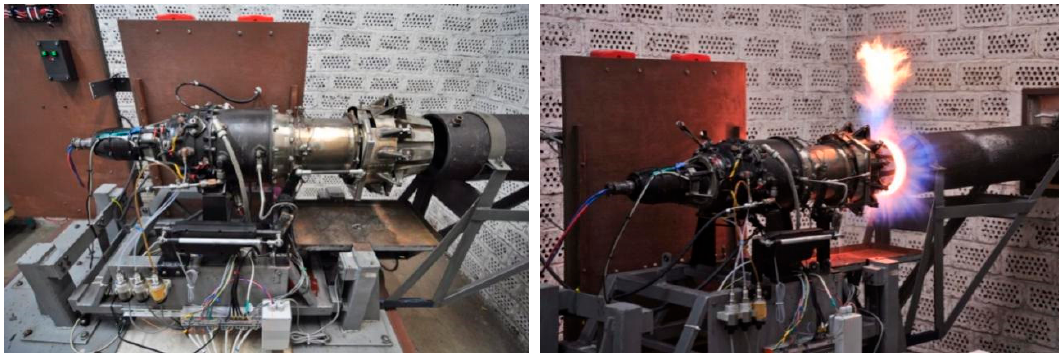
Figure 9. Views of the iSTC-21v turbojet engine (left) and its starting process (right) in a laboratory.